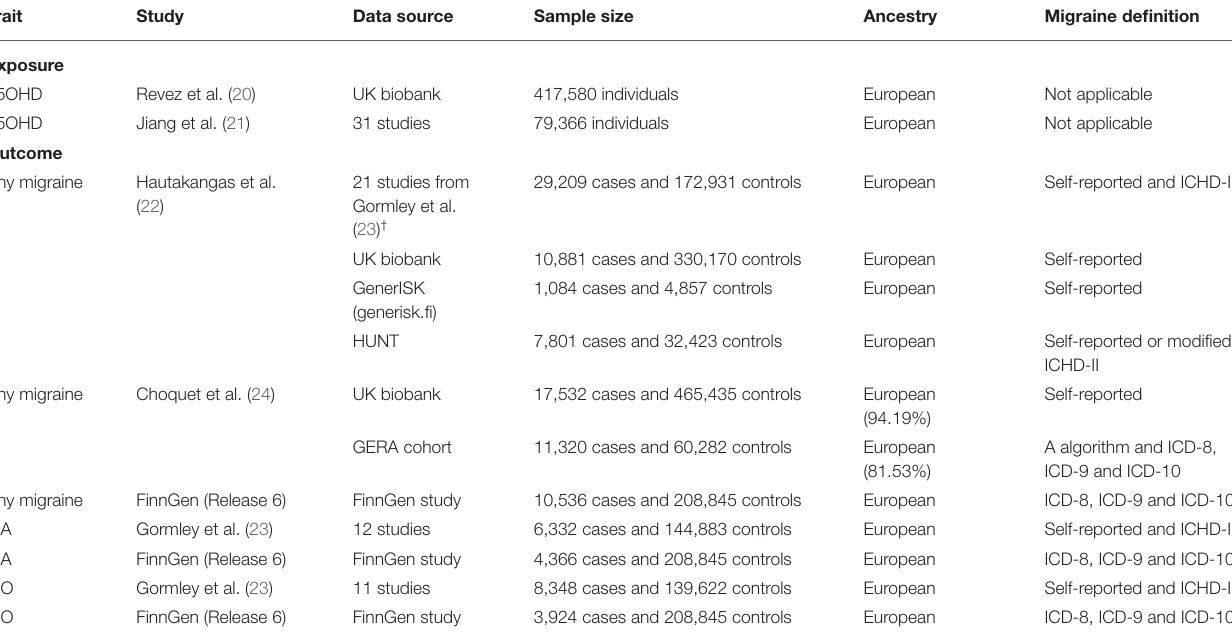
TABLE 1 | Characteristics of GWAS